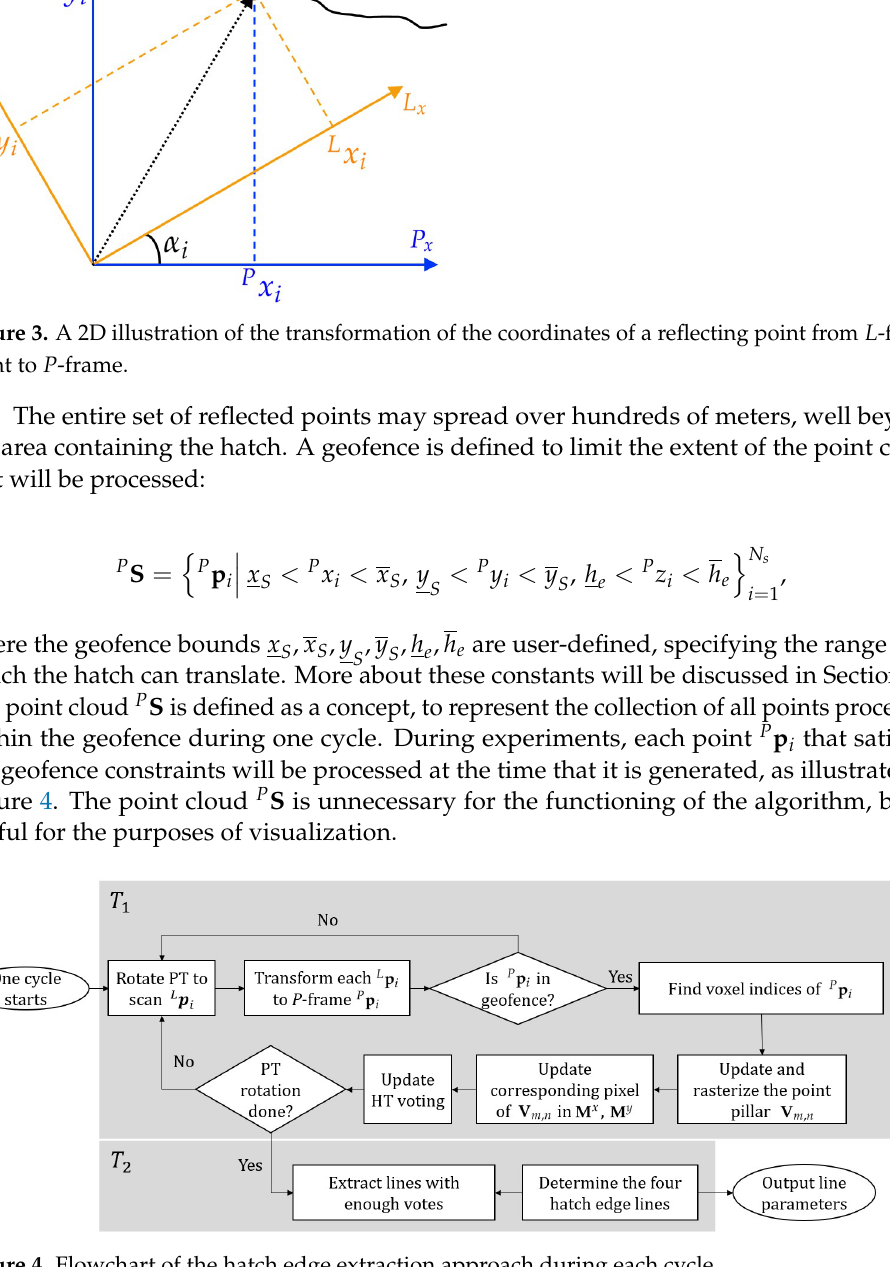
Figure 4. Flowchart of the hatch edge extraction approach during each